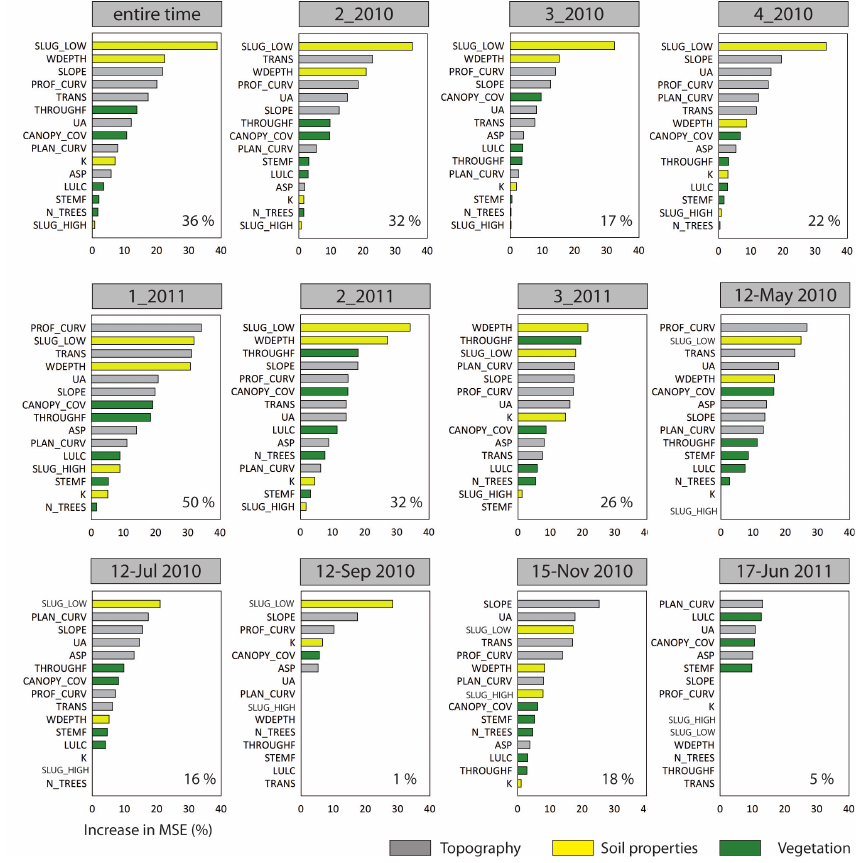
Fig. 6. Variable importance plots of random forest models predicting the water table response variable INDEX ACTI for different temporal scales (entire time, seasonal scale, and event scale). The x-axis displays the percentage of increase in mean square error (MSE) when the data for that predictor are permuted randomly while all others are held constant. The numbers in the lower right corner of each variable importance plot is the percentage of explained variance for that random forest